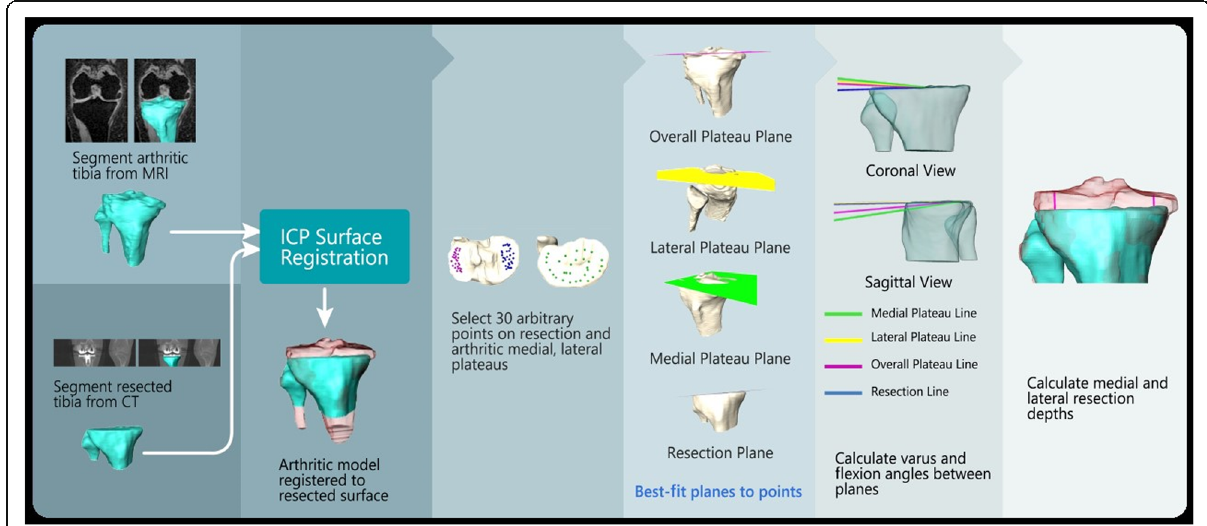
Fig. 1 Registration process of surface models, point selection, plane fitting, and calculations. [The registration process for the various steps are represented. Panels one and two represent pre-operative MRI and post-operative resected CT surface models; panels three and four represent point selection and plane fitting, respectively; panels five and six represent